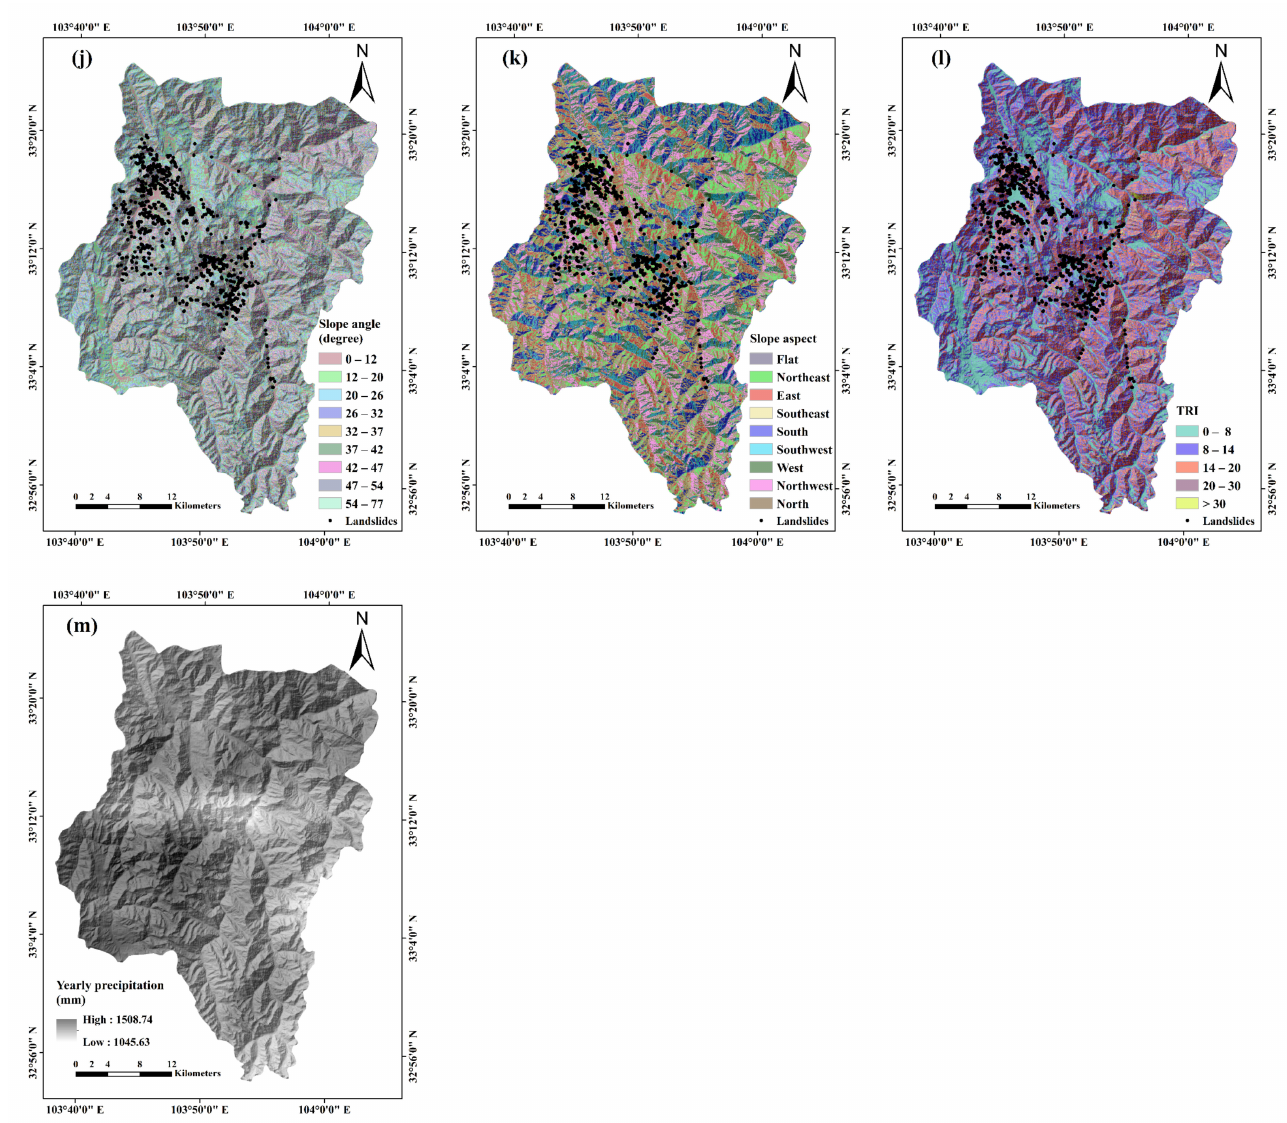
Figure 2. Maps showing landslide predisposing factors used in Zhangzha Town: ( a ) PGA, ( b ) TWI, ( c ) distance to rivers, ( d ) distance to roads, ( e ) NDVI, ( f ) land use, ( g ) lithology, ( h ) distance to faults, ( i ) elevation, ( j ) slope angle, ( k ) slope aspect, ( l ) TRI, and ( m ) yearly